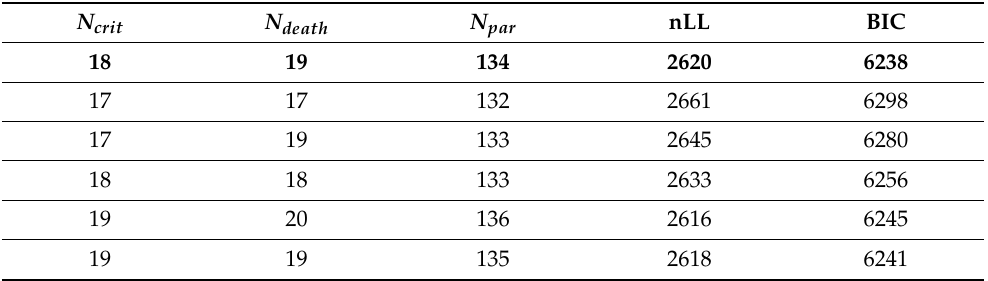
Table A2. Determination of the number of time steps of input step functions. We analyzed different numbers of steps for the step functions p crit ( N crit ) and p death ( N death ). Npar = number of parameters to be estimated, nLL = negative log-likelihood, BIC = Bayesian information criterion. A total of 1714 data points were analyzed (348 new cases and death cases measurements daily and cumulative, 322 measurements of daily critical cases). The combination N crit = 18 and N death = 19 resulted in the lowest BIC, i.e., best compromise between model parsimony and fit. The best solution resulted from estimation of 134 parameters as follows: 15 basic parameters (Table A5), 28 of infectivity changes at 19 time points (Table A1), 18 values for α crit , i with respect to 17 time points and 19 values for α death , i with respected to 18 time points. Alternative assumptions on N crit and N death resulted in respective changes of the total number of parameters. The best results are in bold. N crit N death